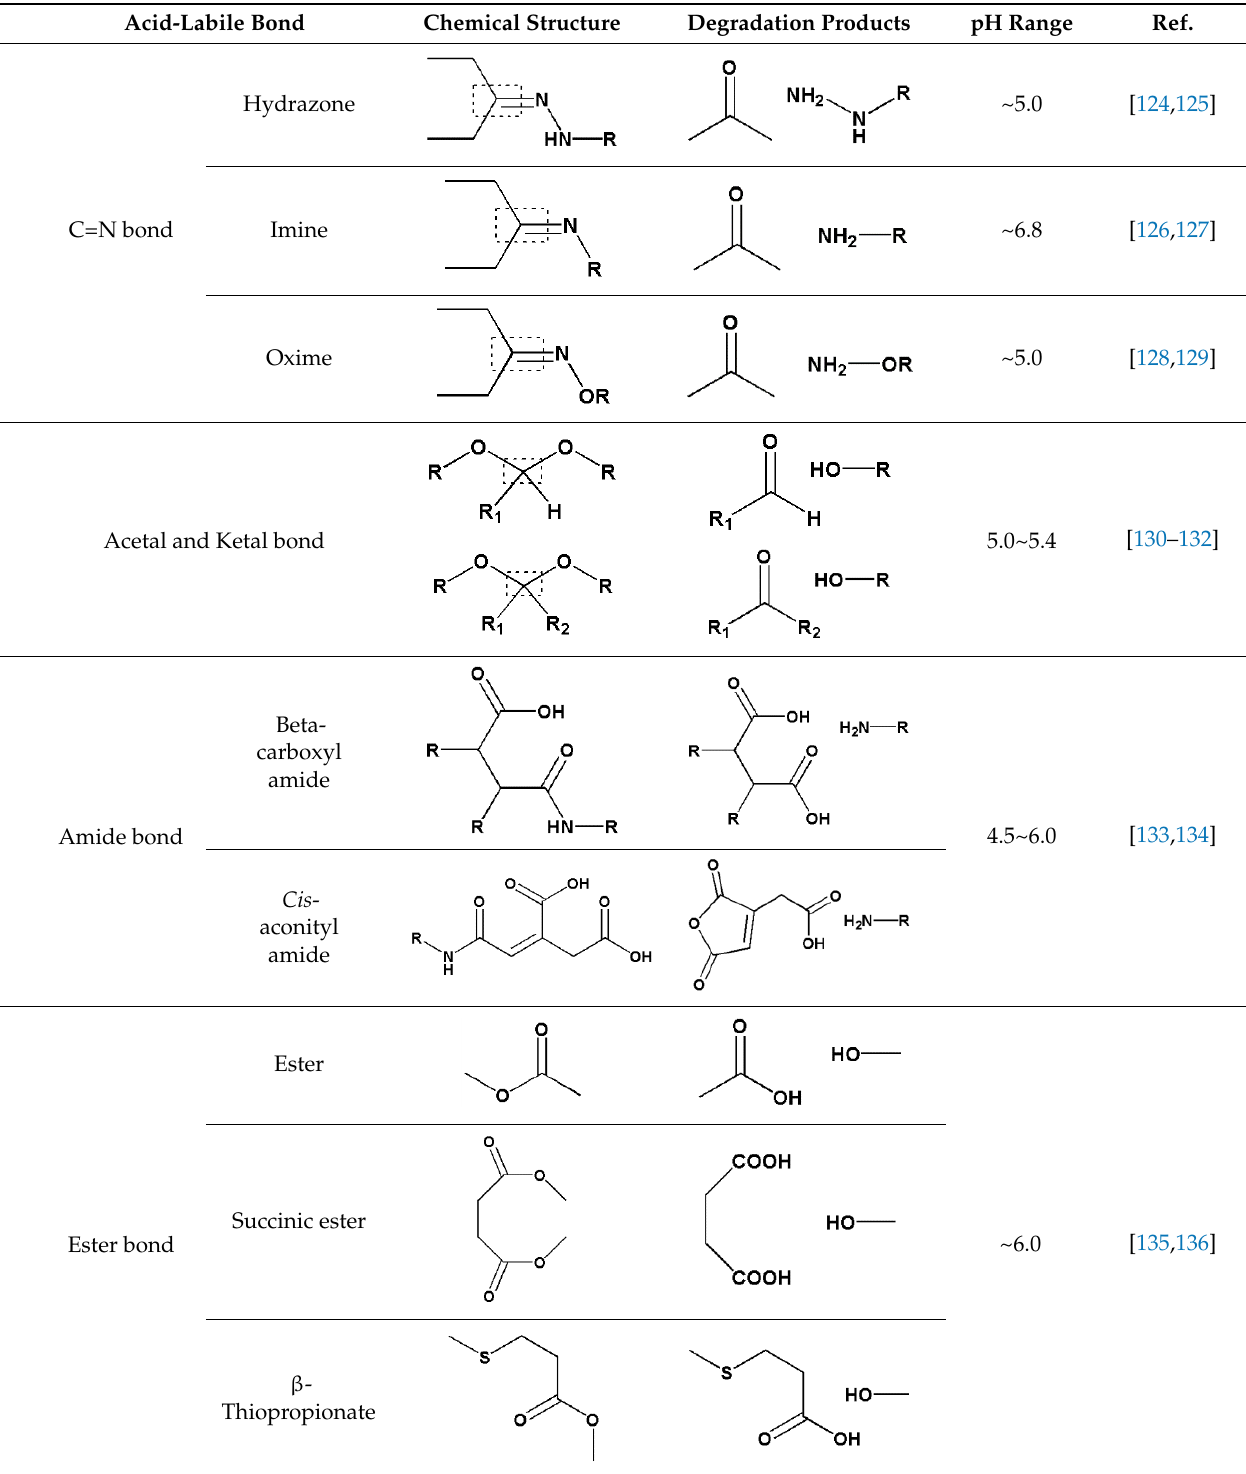
Table 3. Acid-labile chemical bonds and their degradation products.